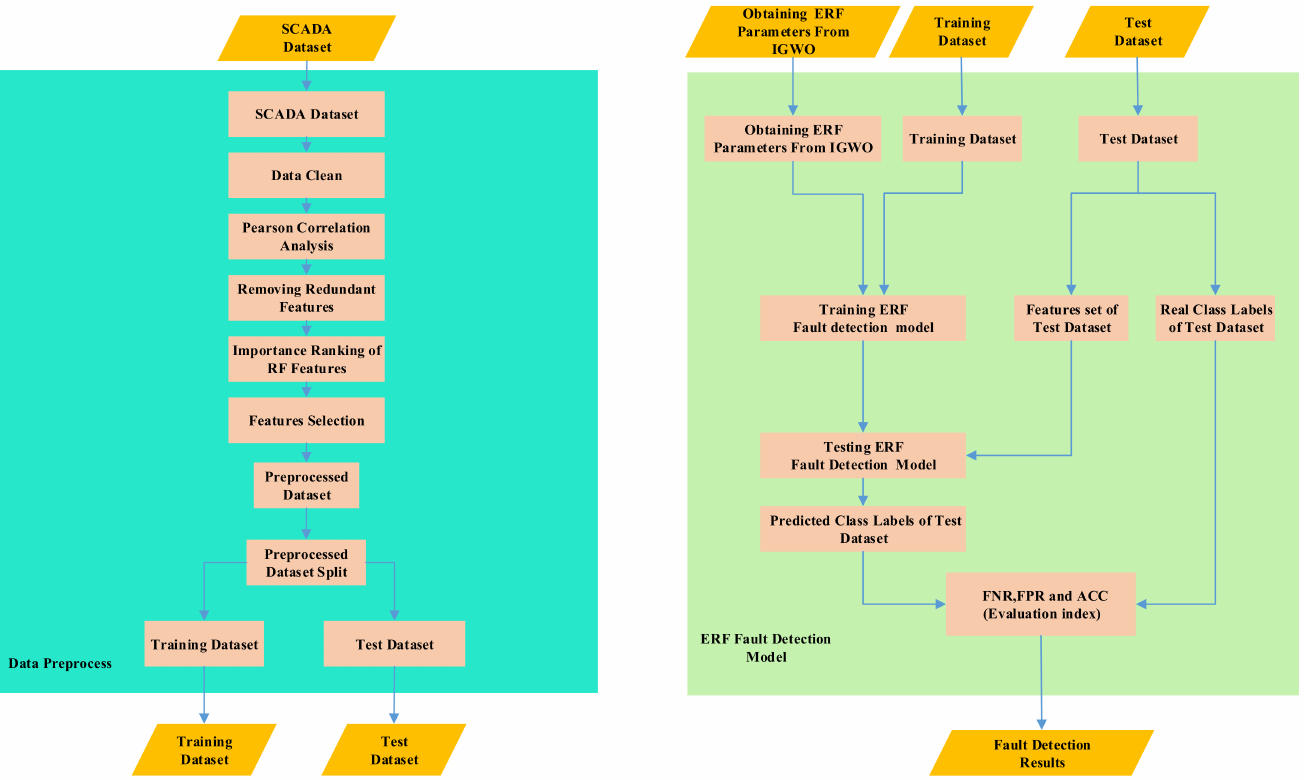
Figure 3. The flow chart of Data Preprocess and ERF Fault Detection Model. During the optimization of the Extreme Random Forest parameters using the im- proved grey wolf optimization, the above two parameters (Table 1) are set into a two- dimensional vector X ( t + 1) (n_estimators, min_samples_leaf). The fitness of each indi- vidual is calculated during each iteration of the algorithm. If the fitness after iteration is better than the current stage, replace it. Otherwise, discard the current state vector and proceed to the next iteration until the maximum number of iterations is met or the accuracy requirement is met. The pseudo code of the optimized Extreme Random Forest parameters based on improved grey wolf optimization is shown in Algorithm